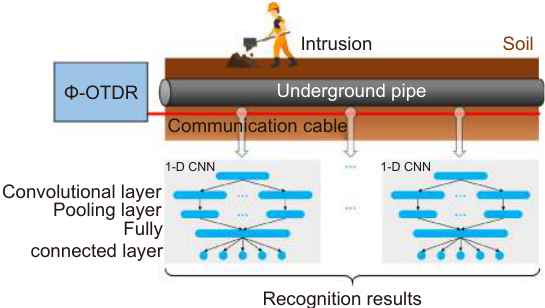
Fig. 8 | Fiber cable layout and operation principle of 1D-CNN. Figure redrawn after ref. 192